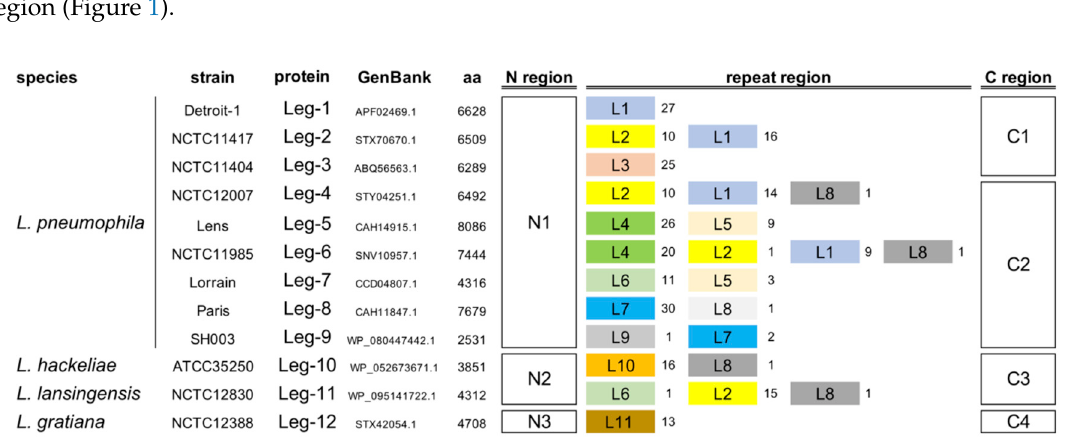
Figure 1. Modularity of Legionella repeats-in-toxins (RTX) proteins. The organization of the RTX proteins encoded by L. pneumophila and other Legionella species is diagrammed. N regions, C regions, and L repeats exhibiting > 70% sequence identity have the same number. Repeat types are distinguished by color, with their copy numbers shown to the right. Protein modules were not drawn to scale.